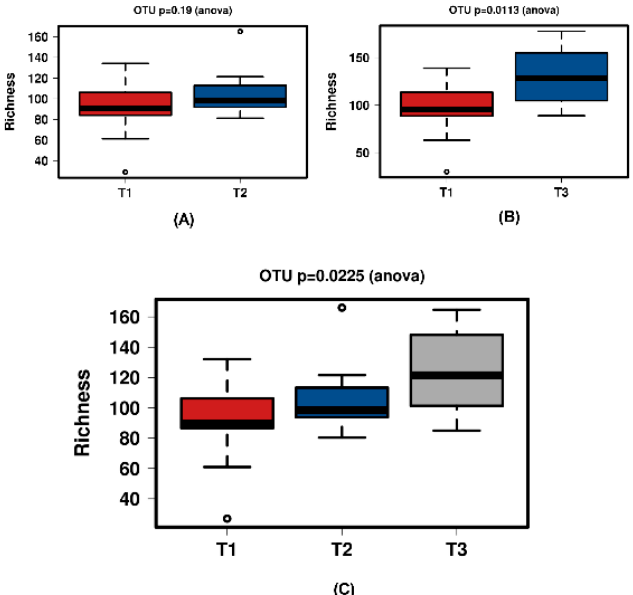
Figure 9. Richness for the ‘natural’ group samples. ( A ) shows T1 and T2 with a significant increase over time. Samples normalised to a read depth of 1163 sequences; ( B ) shows T1 and T3 with a significant increase over time. Samples normalised to a read depth of 1158 sequences; ( C ) shows T1, T2 and T3 with a significant increase over time. Samples normalised to a read depth of 1162 sequences.